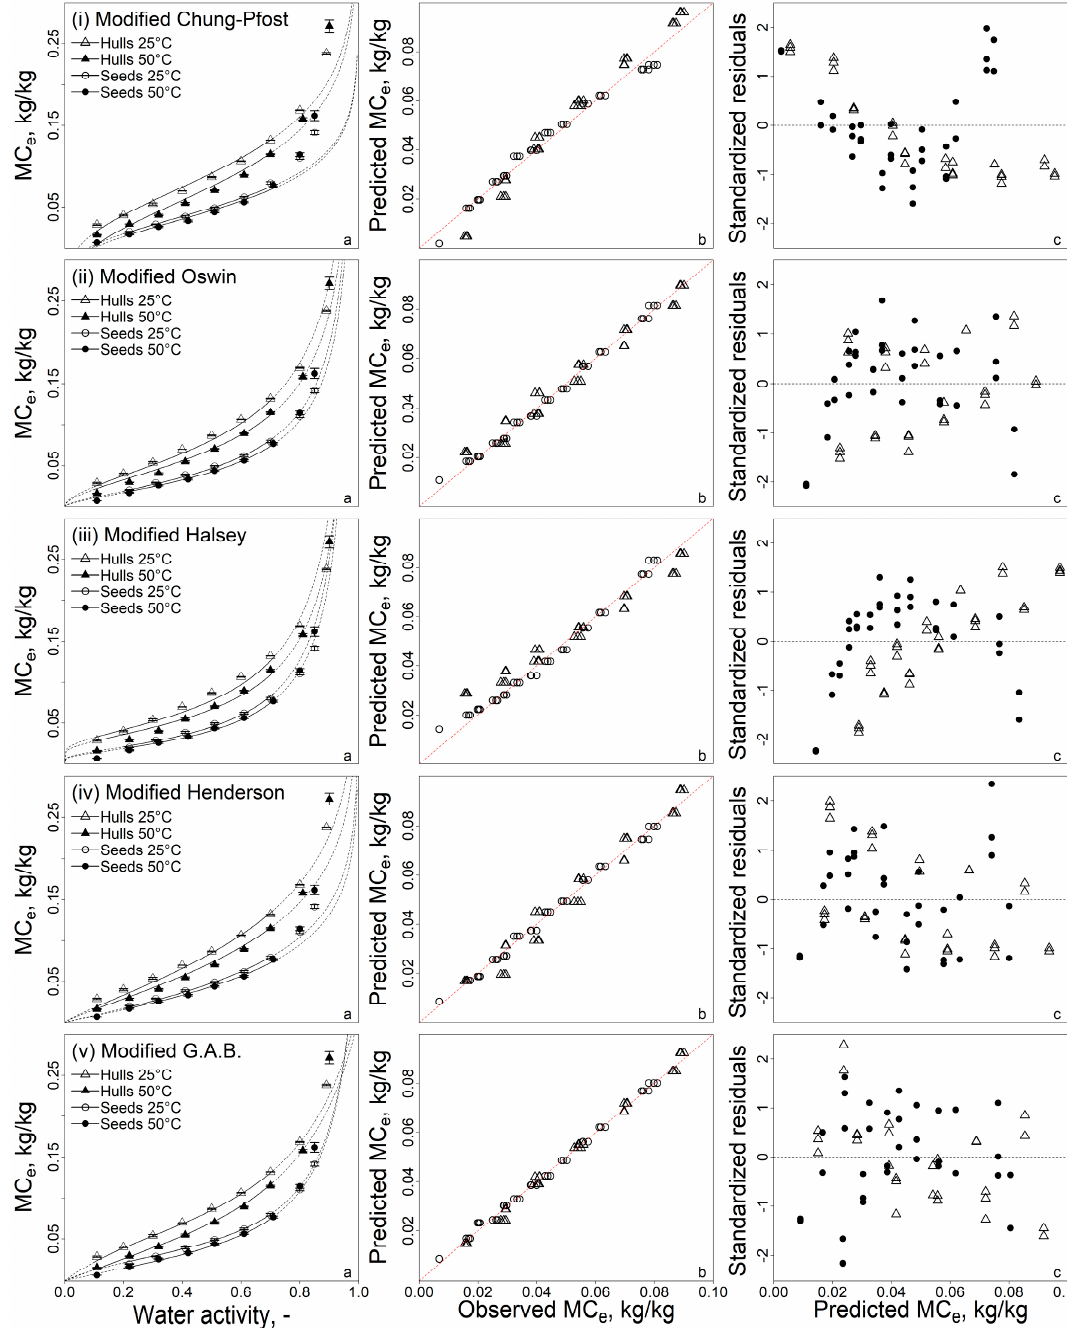
Figure 2. ( a ) Sorption isotherm for high oleic sunflower seeds (circles) and hulls (triangles) at 25 ◦ C (hollow) and 50 ◦ C (solid) predicted with different models as specified in the plot. Slashed lines are an extrapolation beyond the dataset used for fitting. ( b ) observed equilibrium moisture content vs. predicted equilibrium moisture content and ( c ) standardized residuals vs. predicted equilibrium moisture content.